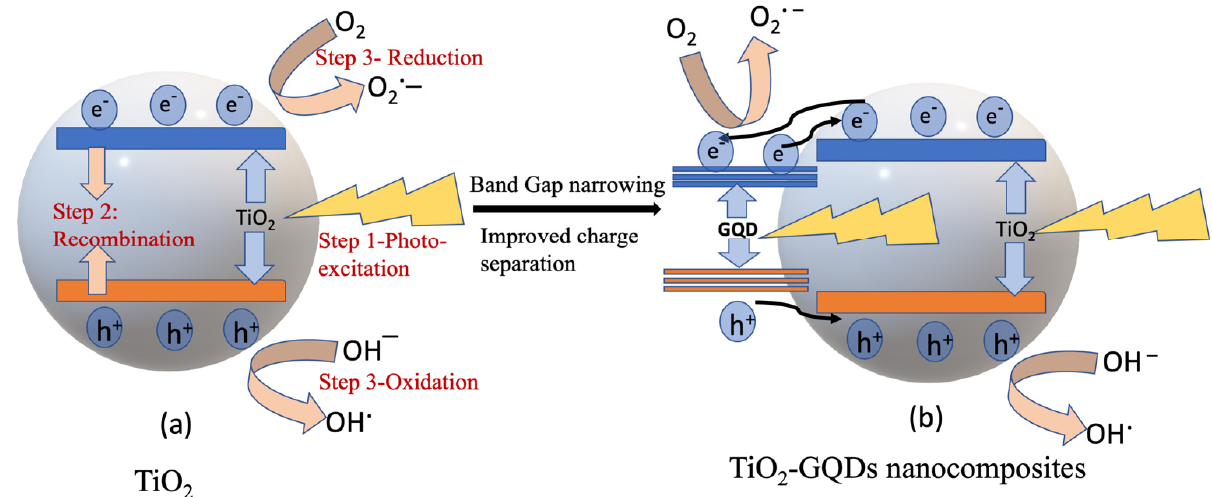
Figure 23. ( a ) Photocatalysis on TiO 2 nanoparticles; ( b ) bandgap narrowing and charge separation on TiO 2 -GQD nano- composites.